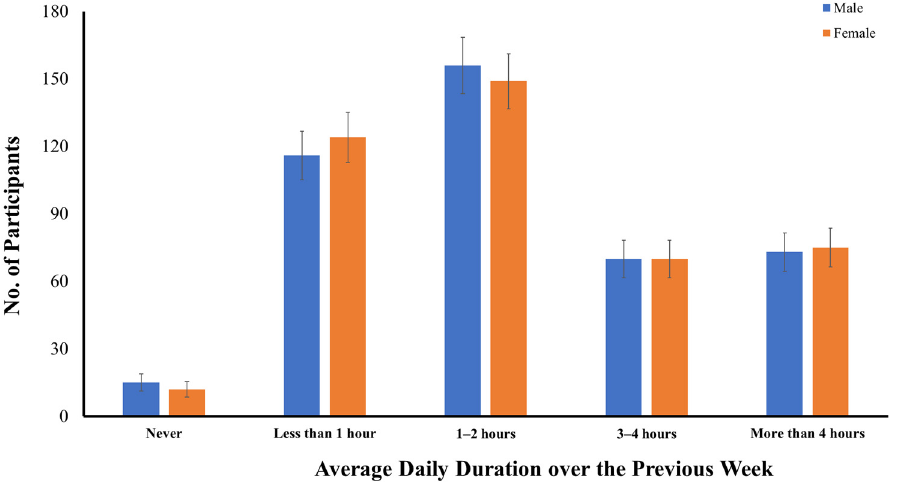
Figure 1. Distribution of early adolescents categorized across gender based on their average daily time spent using a smartphone over the previous week.